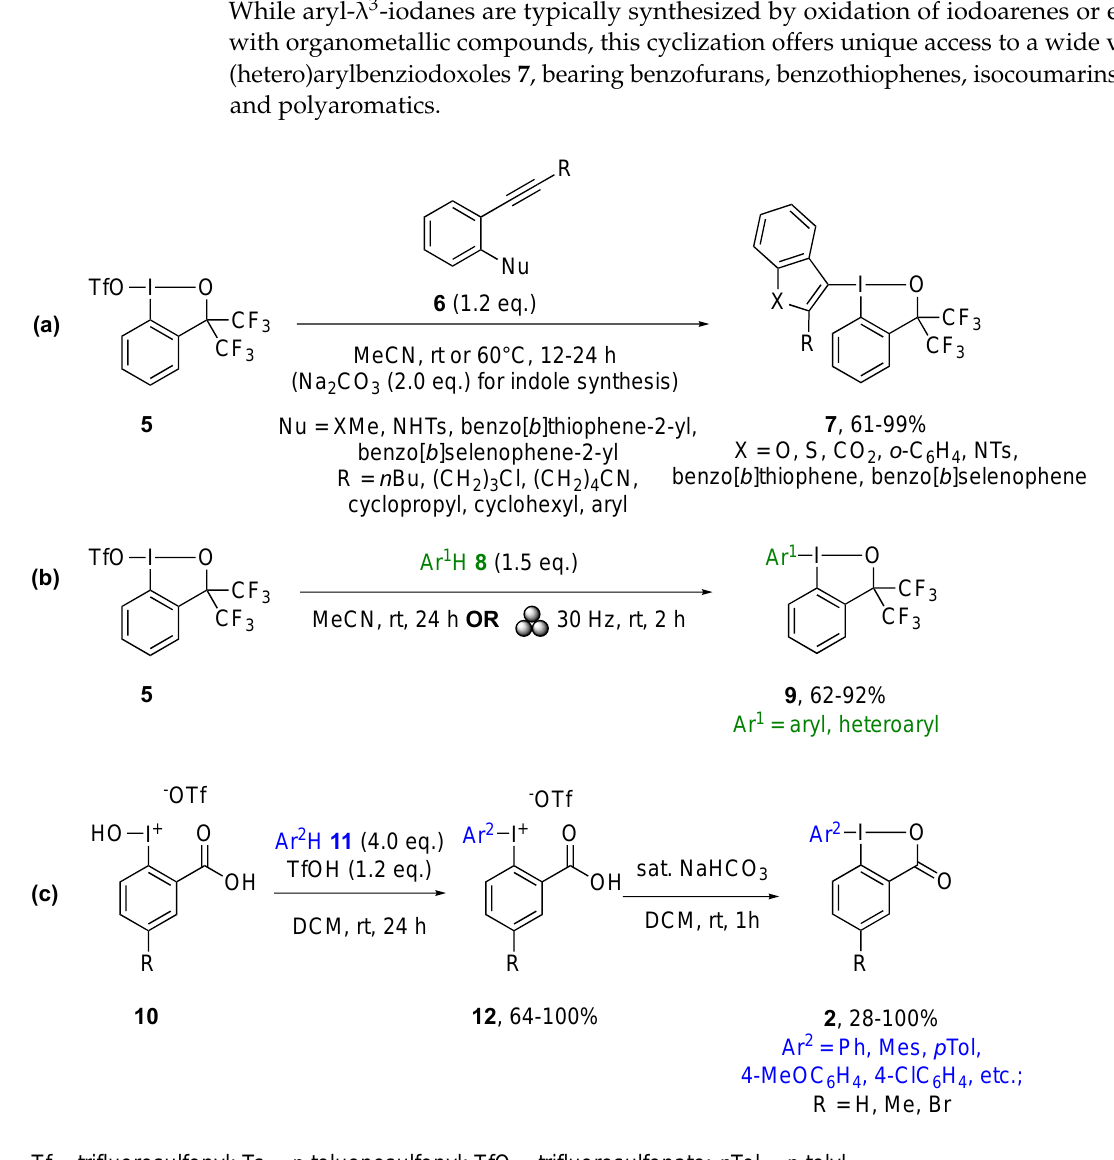
Scheme 3. Synthesis of various (hetero)arylbenziodoxoles 7, 9, and 2 from hypervalent iodine reagents 5 and 10, respectively. See explanation of reactions ( a – c ) in the